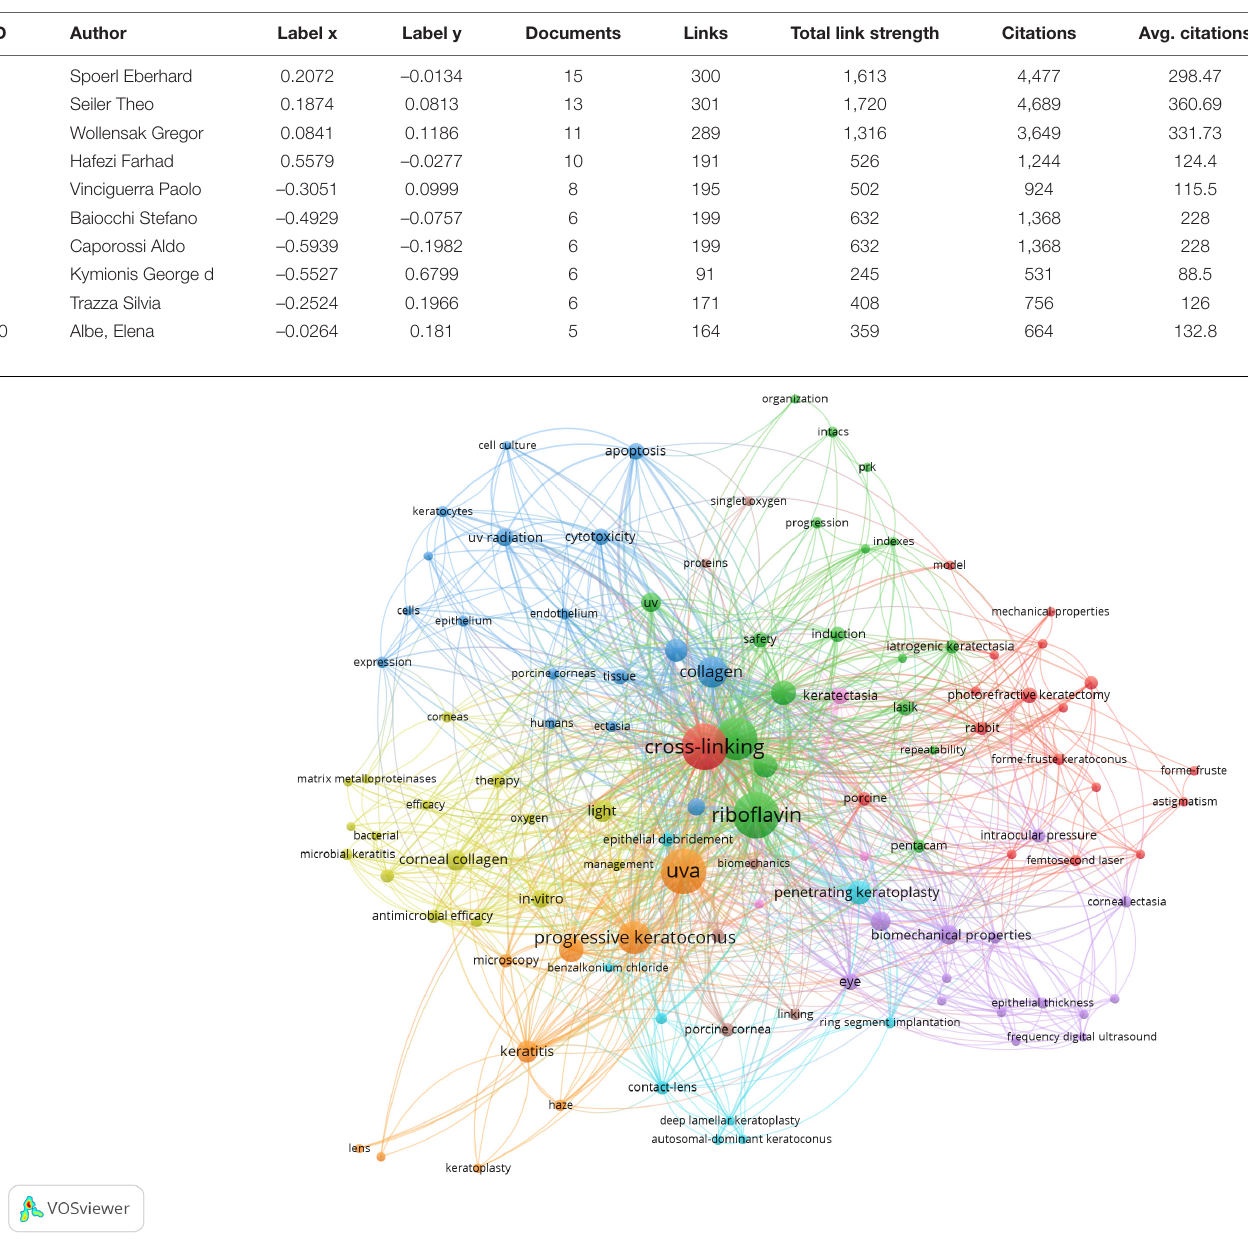
FIGURE 4 | The co-occurrence network of keywords. The node represents the keyword, and its size is associated with the occurrence counts of the keyword. The link between two nodes means the co-occurrence of the two